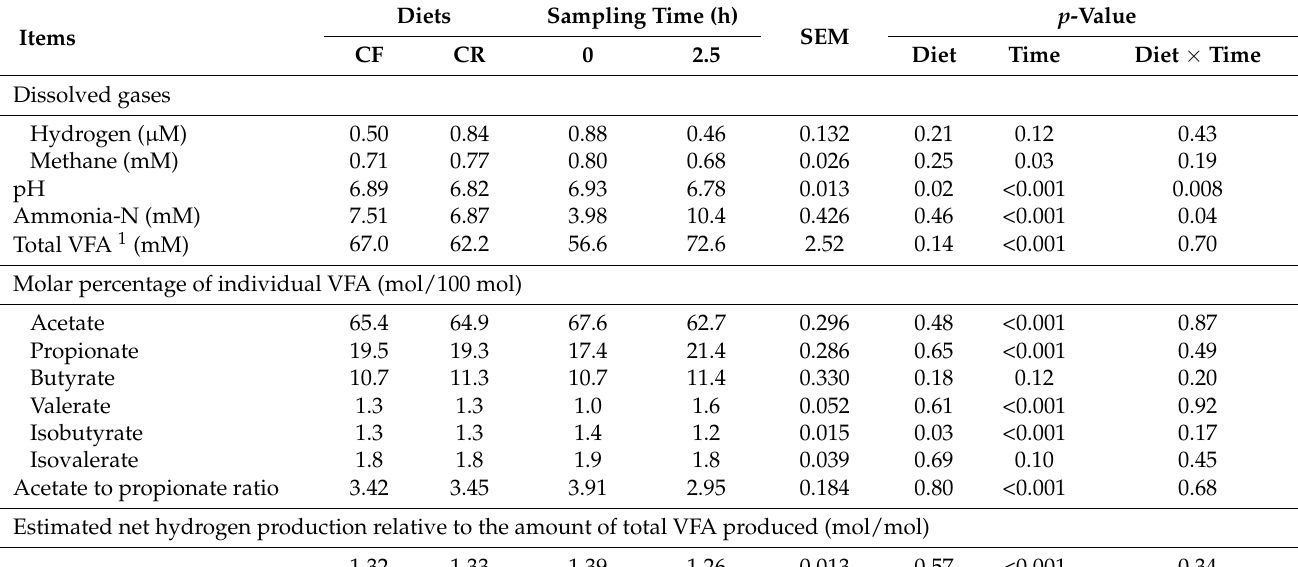
Table 6. Dissolved gases and fermentation end-products in the rumen of beef cattle fed corn stover after fresh-corn harvested (CF) or corn stover after ripe-corn harvested (CR) silage diet (n = 7).